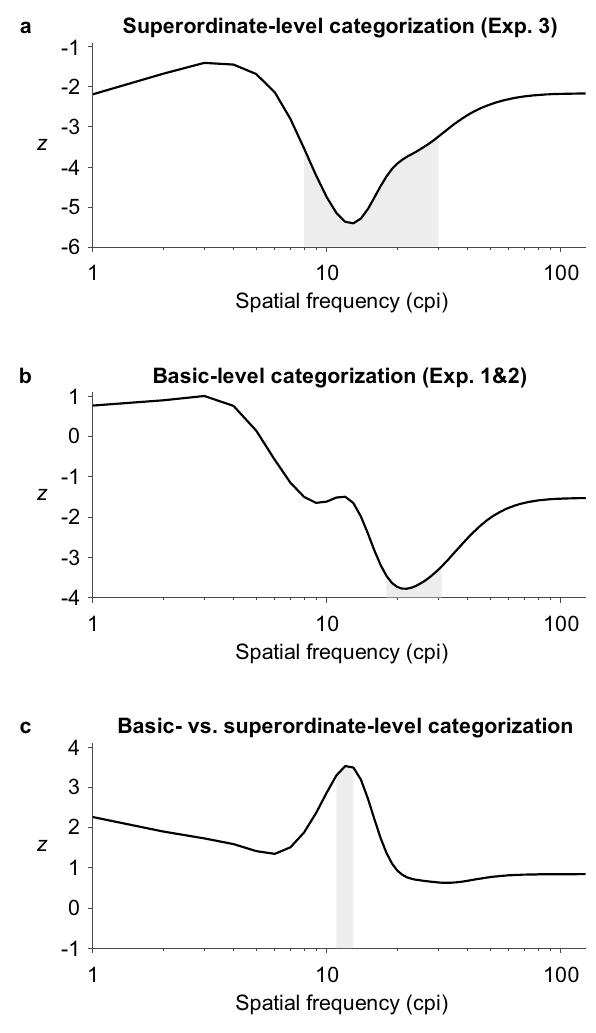
Figure 7. Results of the temporal analysis assessing the time course of SF usage. ( a ) Superordinate-level categorization of indoor vs. outdoor scenes in Experiment 3. ( b ) Basic-level categorization of indoor and outdoor scenes (pooled data from Experiments 1 and 2). ( c ) Differences between basic- and superordinate-level categorization. The z values in ( a ) and ( b ) are z scored linear slopes indicating the usage of each SF across time (positive values indicate increasing usage across time and negative values indicate decreasing usage across time). The z values in ( c ) correspond to the differences between the slopes shown in ( a ) and ( b ). The grey areas indicate slopes (or differences between slopes) that are significantly different from zero. cpi = cycles per